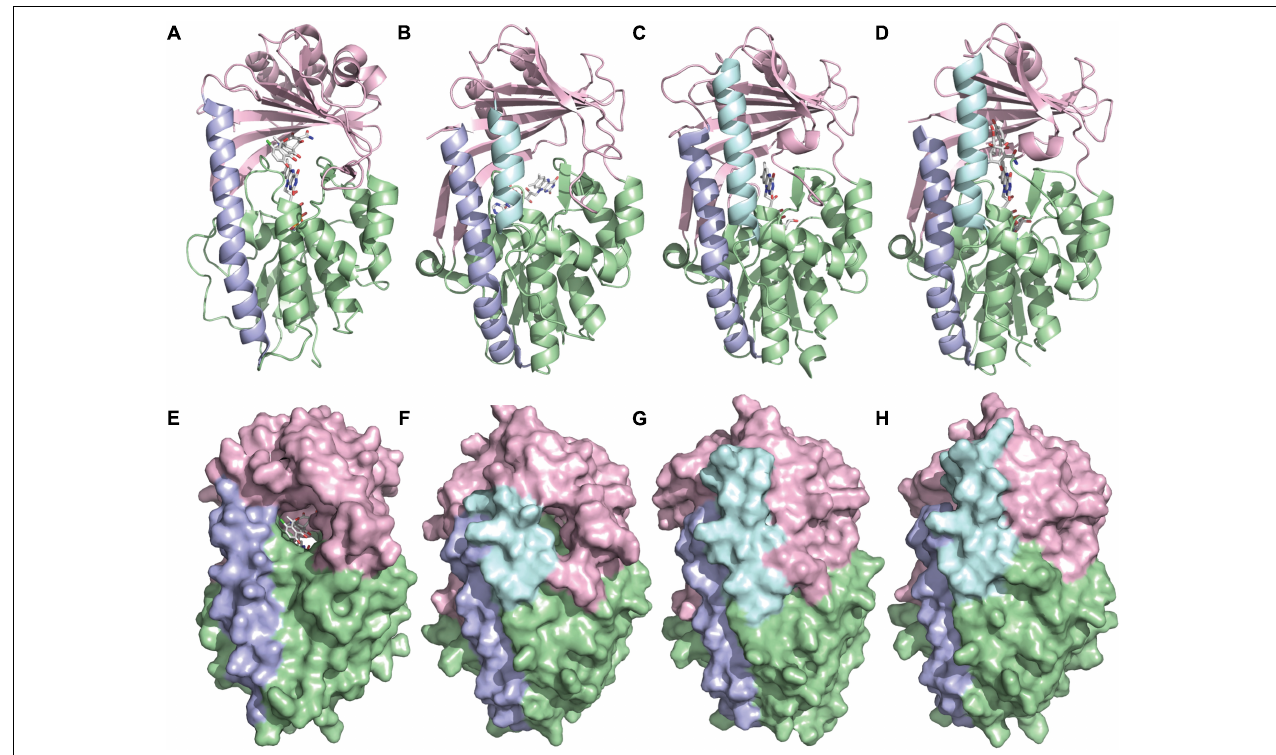
FIGURE 4 | X-ray crystal structure of a tetracycline destructase with bound tetracycline substrate and flavin cofactor. The mobility of the flavin cofactor is highlighted by showing the FAD-IN and FAD-OUT conformations observed during structural studies. (A) X-ray crystal structure of CTc bound to TetX (FAD-IN conformation, PDB ID: 2y6r). (B) X-ray crystal structure of Tet50 with no bound substrate (FAD-OUT conformation, PDB ID: 5tue). (C) X-ray crystal structure of Tet50 with no bound substrate (FAD-IN conformation, PDB ID: 5tue). (D) X-ray crystal structure of CTc bound to Tet50 (FAD-IN conformation, PDB ID: 5tui). (E) Surface view of X-ray crystal structure of CTc bound to TetX (FAD-IN conformation, PDB ID: 2y6r). (F) Surface view of X-ray crystal structure of Tet50 with no bound substrate (FAD-OUT conformation, PDB ID: 5tue). (G) Surface view of X-ray crystal structure of Tet50 with no bound substrate (FAD-IN conformation, PDB ID: 5tue). (H) Surface view of X-ray crystal structure of CTc bound to Tet50 (FAD-IN conformation, PDB ID: 5tui). Images were generated using PyMOL